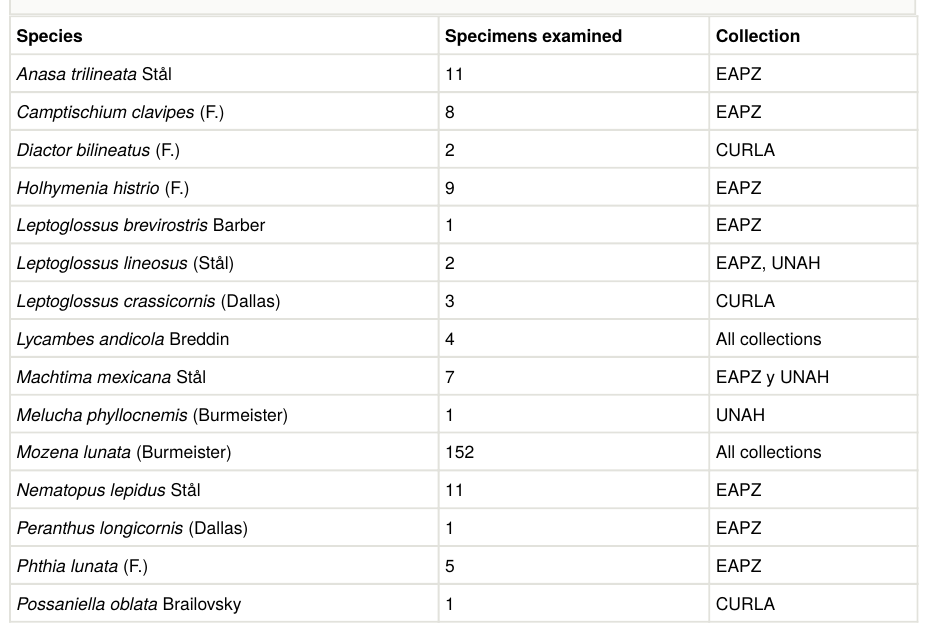
Table 1. New country records of Coreidae for